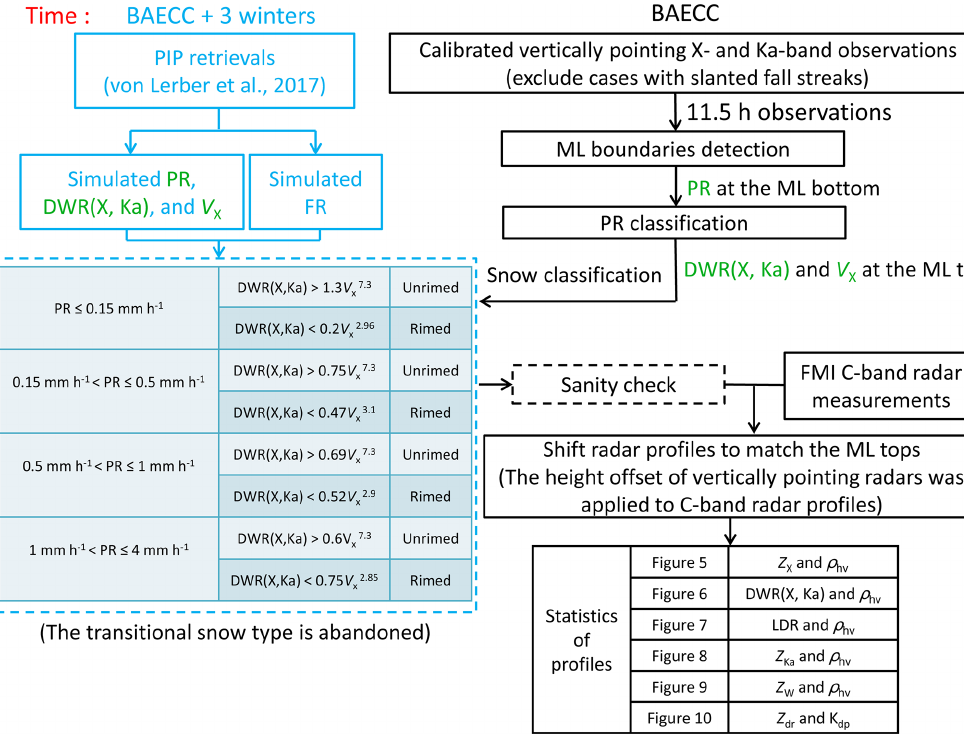
Figure 2. Flow chart of the data process in this study. The snow classification part as discussed in Sect. 3.1 is in light blue. Variables used in snow classification are in green. Radar observations during BAECC are in black. The sanity check in the next section is represented by the dashed black diagram.